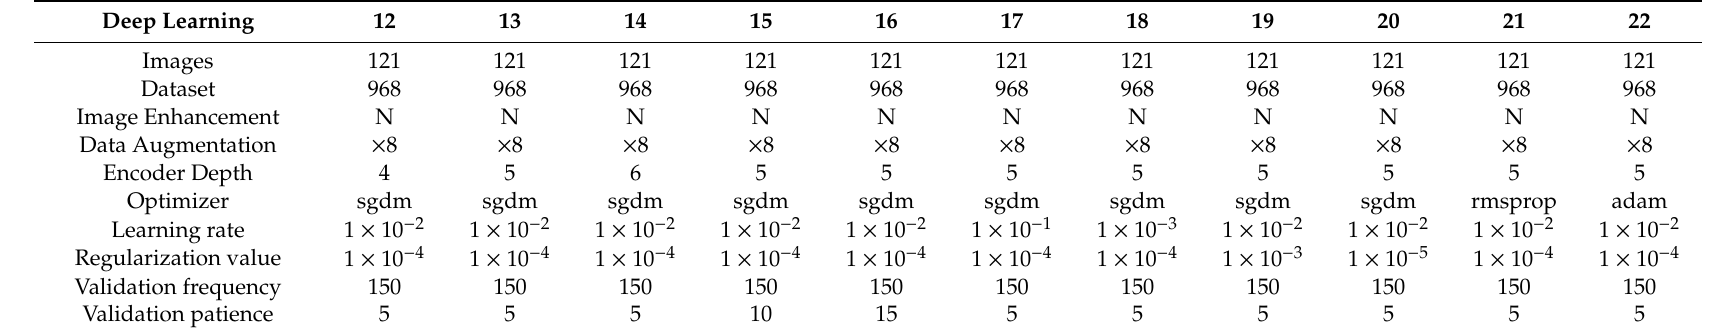
Table A2. Deep-learning model’s parameters (2 /